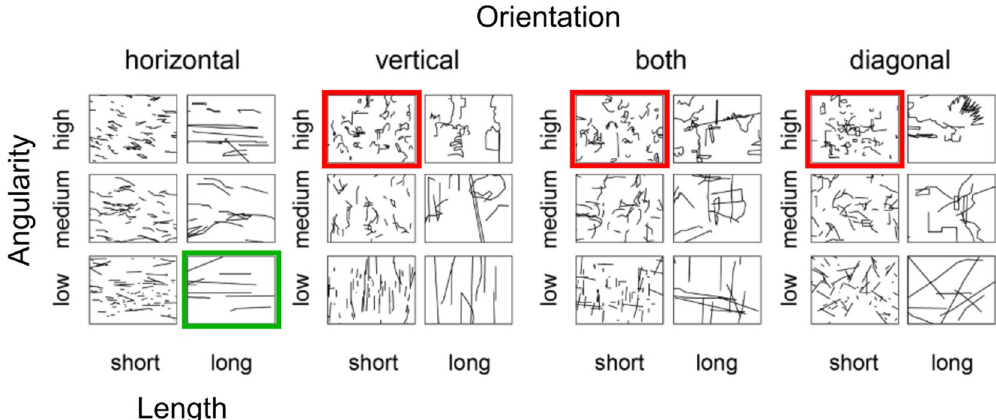
Figure 3. Sample abstract scenes with different combinations of features. One example is shown for each bin. The image outlined on the bottom row is considered the most positive/safe according to the results of Experiment 2. The three images outlined on the top row are considered the most